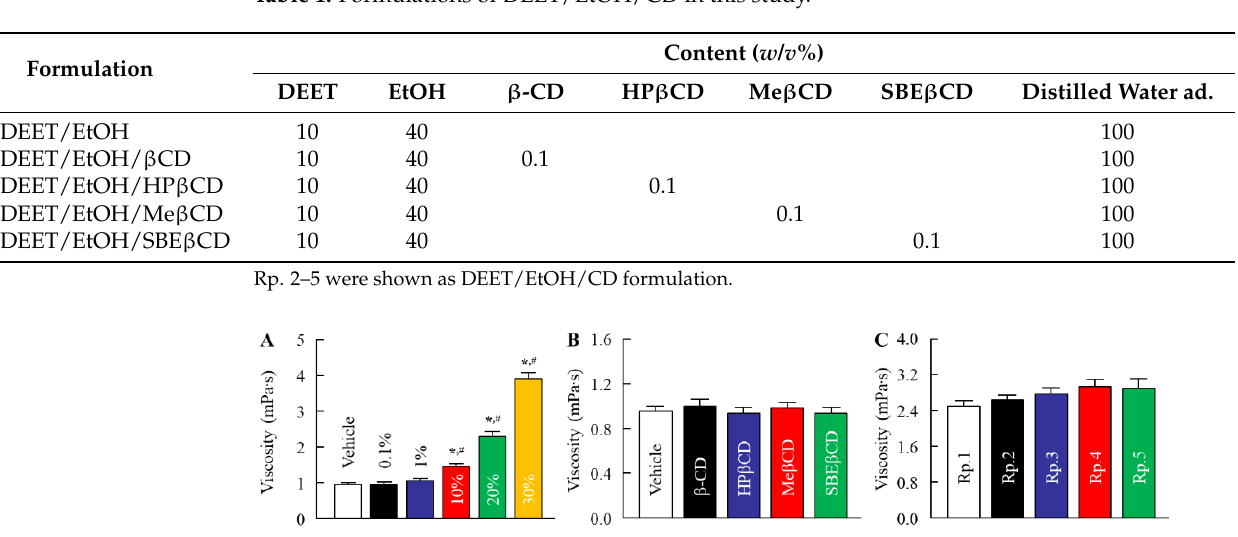
Figure 2. Effect of each CD on the viscosity in the DEET/EtOH/CD formulations. ( A ) Changes in viscosity of the 0.1–30% HP β CD solution. ( B ) Changes in viscosity of the various 0.1% CD solutions. ( C ) Changes in viscosity in the DEET/EtOH/CD formulations (Rp. 1–5 formulations). The compositions of DEET/EtOH/CD (10:40:0.1,%) formulations (Rp. 1–5 formulations) are shown in Table 1. n = 5. * p < 0.05 vs. Vehicle for each category. # p < 0.05 vs. Rp. 1 formulation. The viscosity in the DEET/EtOH formulations containing 0.1% CD (Rp. 2–5 formulations) were not observed to be significantly different in comparison with formulations without CD (Rp. 1 formulation).